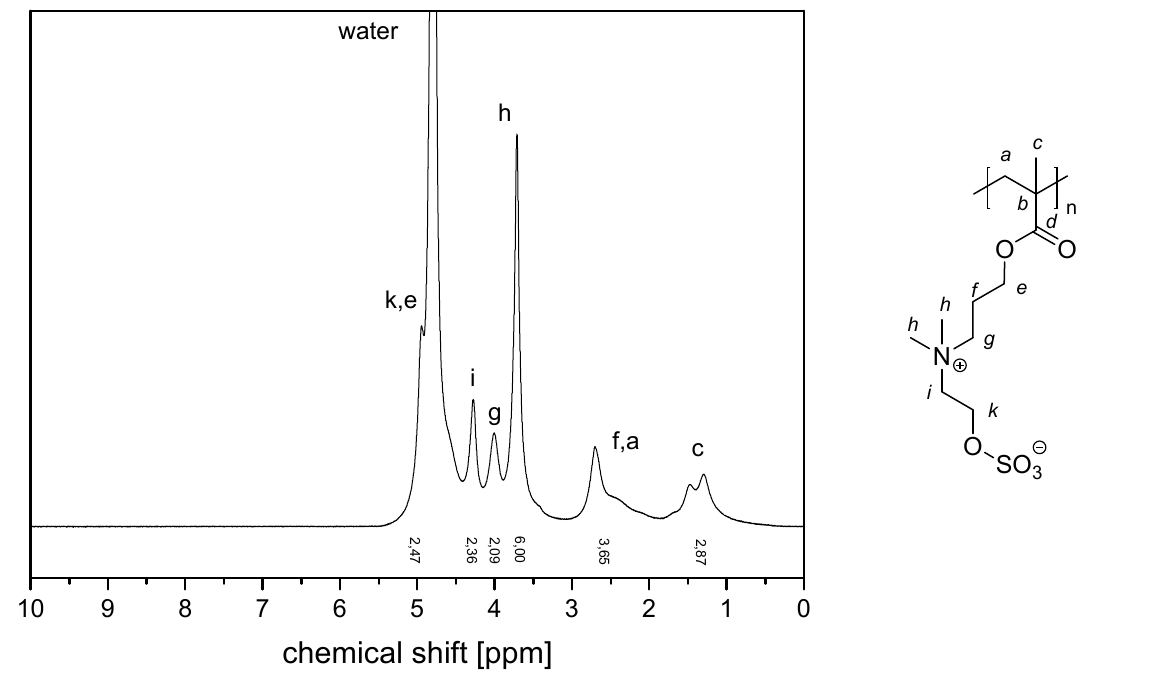
Figure A13. 1 H NMR-spectrum of polymer P − 2c in D 2 O saturated with NaCl.